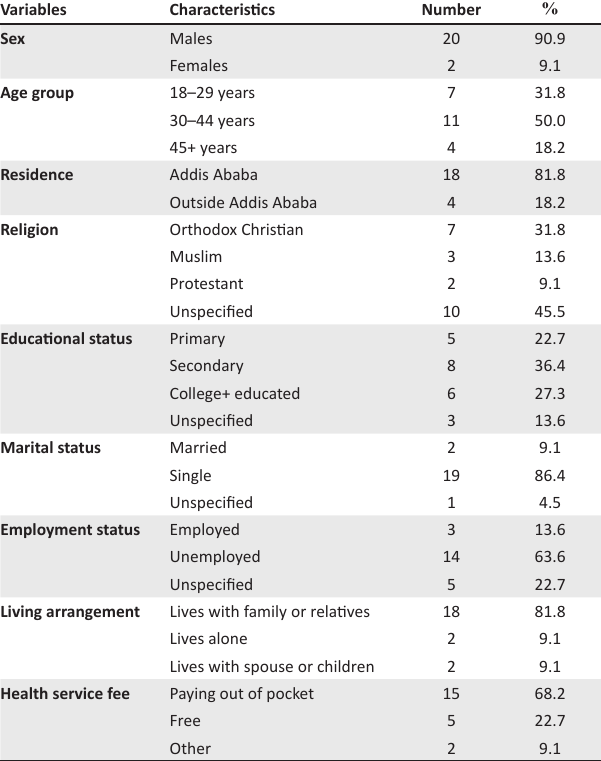
TABLE 2: Clinical and laboratory characteristics of patients treated with clozapine in Zewditu Memorial Hospital, Addis Ababa, Ethiopia, March 2019.